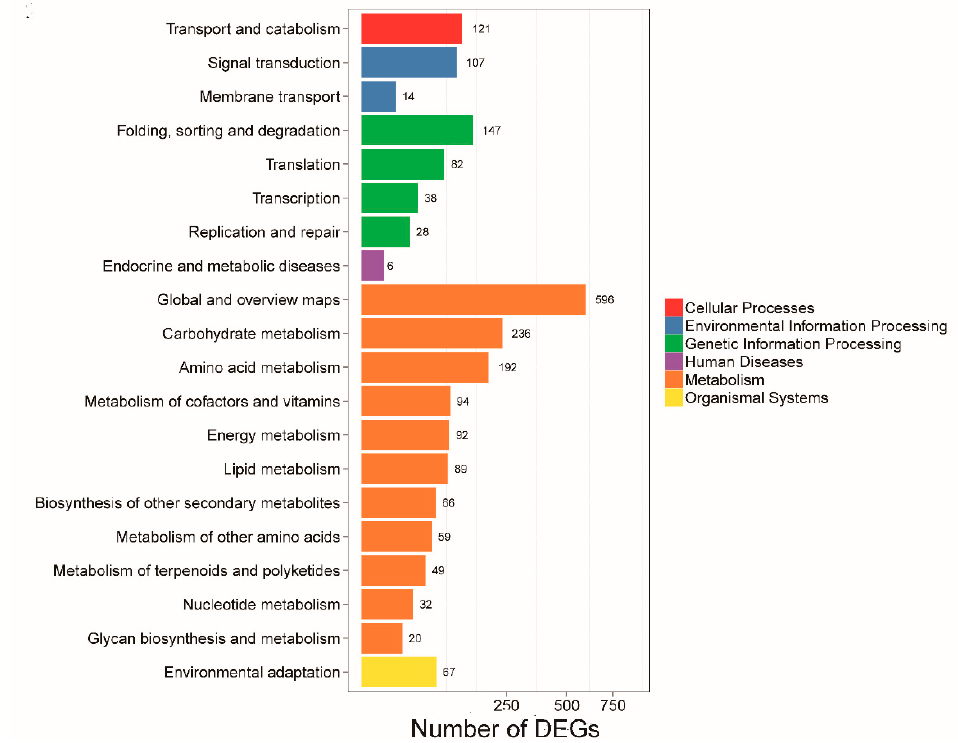
Figure 6. KEGG pathway enrichment analysis of 2,013 DEGs.